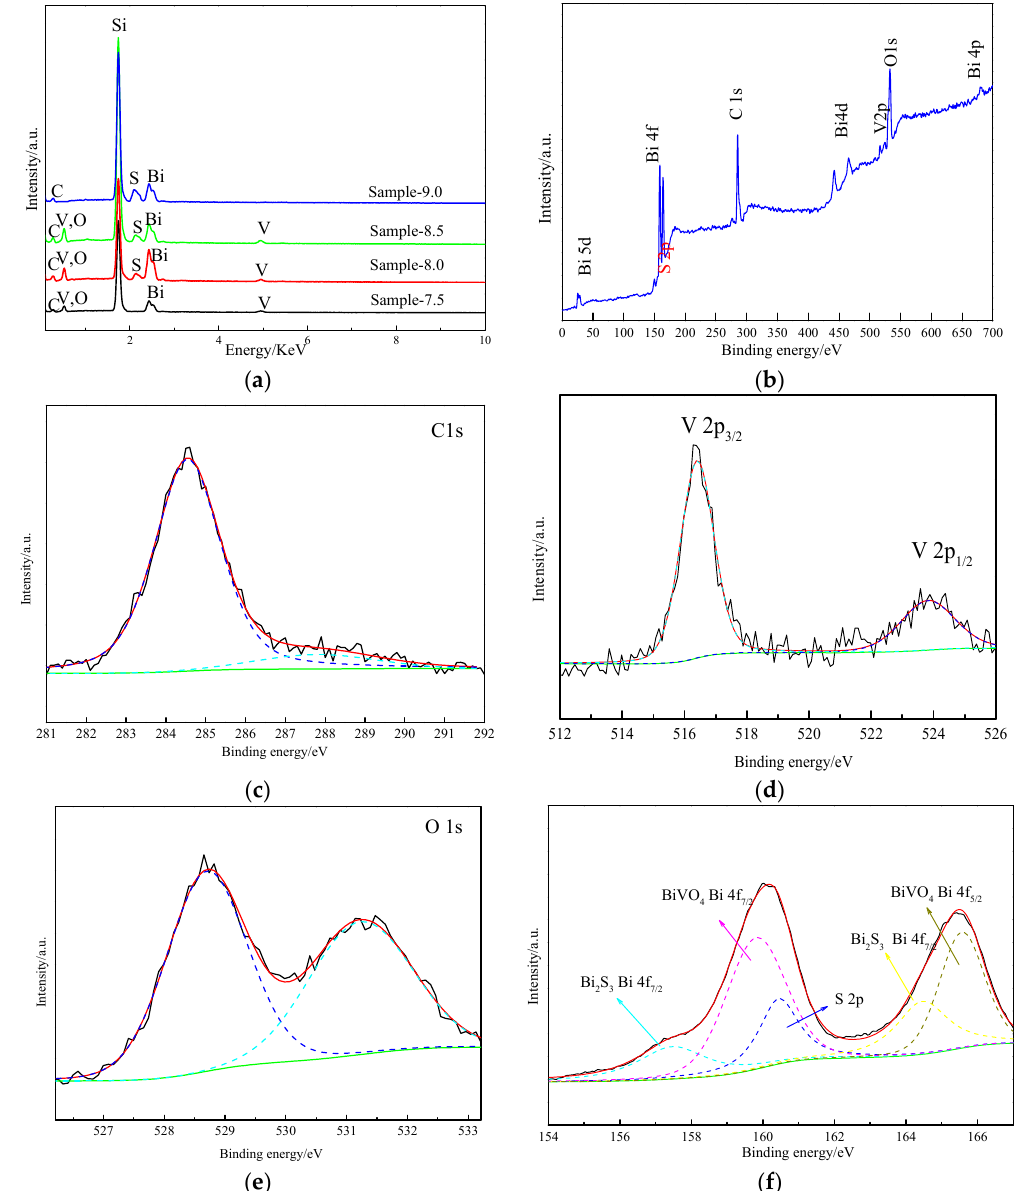
Figure 3. Energy dispersive X-ray detector (EDX) spectra of all samples ( a ) and X-ray photoelectron spectra (XPS) spectra of Sample-8.0 ( b – f ): ( b ) survey XPS spectrum, ( c ) C 1 s peaks, ( d ) V 2 p 3/2 and V 2 p 1/2 peaks, ( e ) O 1 s peak, and ( f ) Bi 4 f 5/2, Bi 4 f 7/2 and S 2 p peaks.